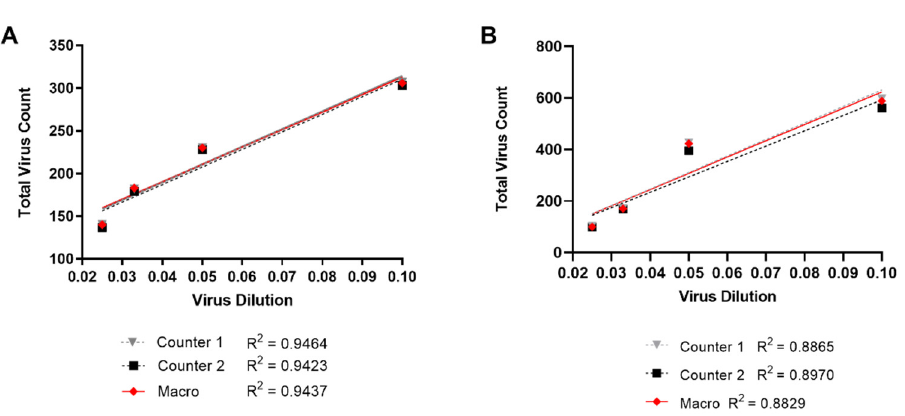
Figure 4. Virus identification comparison between manual counting and the Overlap Intensity macro. Dual-labelled virus signal at 1/10th, 1/20th, 1/30th, and 1/40th dilutions was adhered to glass ( A ) or added to CHME3 cells plated on glass coverslips ( B ) and imaged for GFP. Ten images were taken per dilution. Two independent counters manually identified ROIs for all dilutions. The Overlap Intensity macro was used to assess each dilution. A line-of-best fit was generated for the manual counts and compared to GFP counts from the automatic method. Representative experiments are shown.